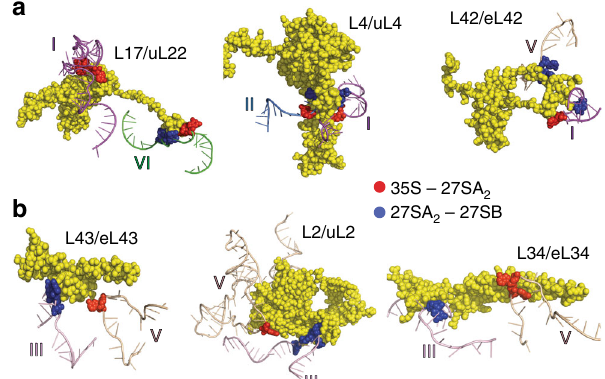
Fig. 4 Models of inter-domain interactions formed during nucleolar stages of 60S assembly. The yellow spheres indicate r-proteins. Predicted protein – rRNA interactions formed during the conversion of 35S of 27SA 2 and the conversion of 27SA 2 to 27SB are indicated with red and blue dots , respectively. Protein-binding sites were de fi ned according to the crystal structure of the ribosome 35 . a Binding of L17/uL22 L4/uL4 and L42/eL42 to domains I ( purple ), V ( wheat ), and VI ( green ) of the 25S during the conversion of 35S to 27SB pre-rRNA. b Sequential binding of L43/eL43, L2/uL2, and L34/eL34 brings domains III ( pink ) and V ( wheat ) in